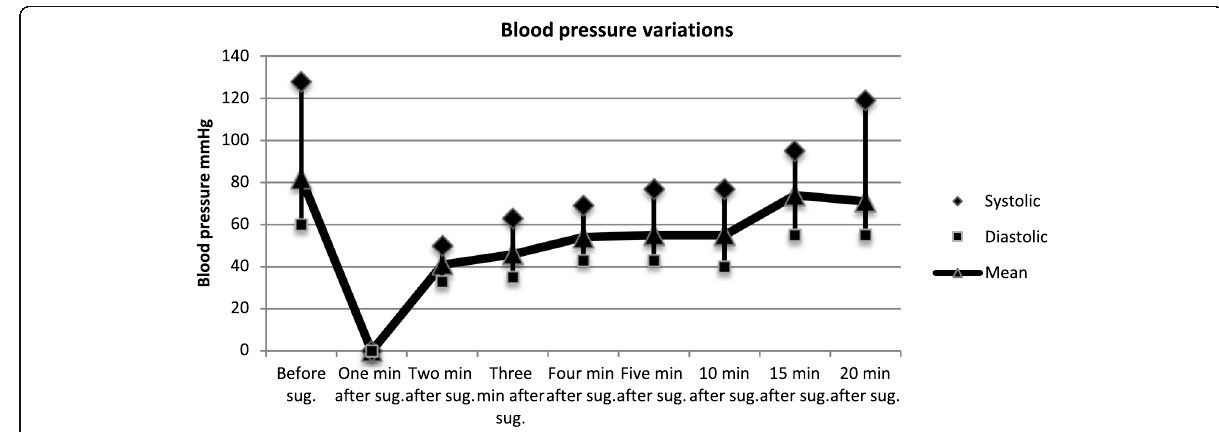
Fig. 1 Blood pressure variations after sugammadex (sug.